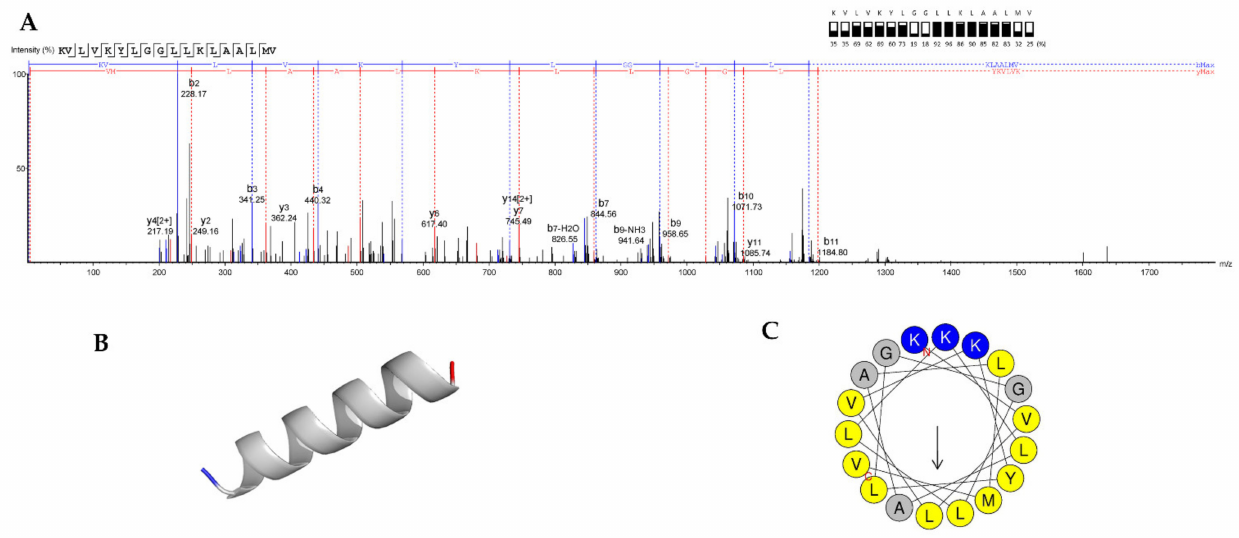
Figure 7. De novo peptide sequencing of the active peptide from WUL10. ( A ) fragmentation nomen- clature of an antimicrobial peptide by tandem MS to generate b and y ions. ( B ) Structural prediction of KVLVKYLGGLLKLAALMV-COOH by PEP-FOLD revealed the α -helix arrangement [30–32]. The 3D structure was predicted by a hidden Markov model structural alphabet, having GDT-TS, Q mean, and TM values of 1.00, 0.99, and 0.89, respectively. The sOPEP energy of the structure was − 39.57 kCal/mol. ( C ) Helical wheel projection of the selected peptide by HeliQuest [33]. The hydrophobic and cationic motifs are shown as yellow and blue colors, respectively. Arrow was the direction of the hydrophobic moment ( µ H). GDT-TS (global distance test—total score), TM (template modeling score), sOPEP (0ptimized potential for efficient protein structure